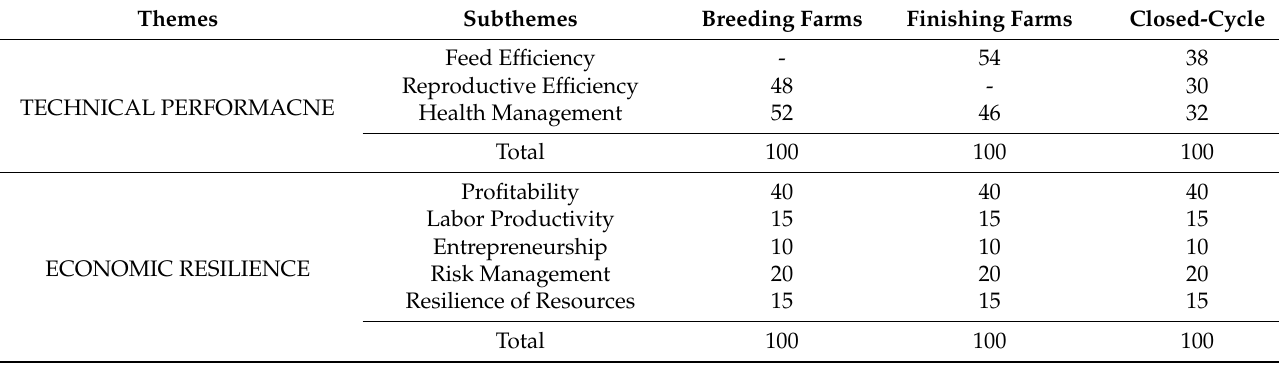
Table 2. Weights used in aggregation of subthemes into themes of economic